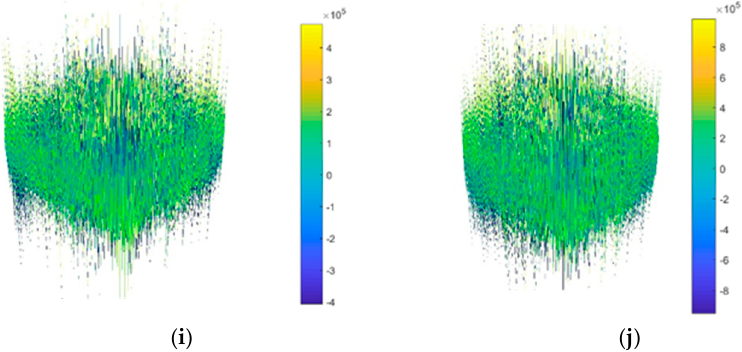
Figure 8. Three-dimensional images of confused and diffused DEM A. The numbering sequence is consistent with the encryption round.